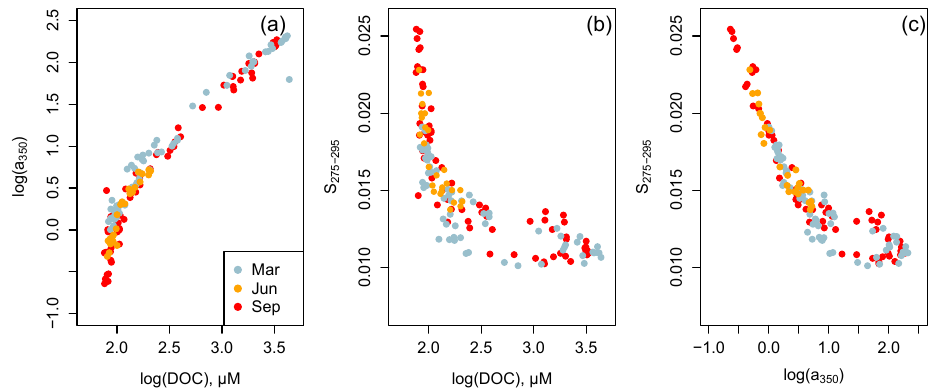
Figure 5. Scatter plots of (a) CDOM absorption versus DOC concentration, (b) S 275–295 versus DOC concentration, and (c) S 275–295 versus CDOM absorption for the entire data set. Strong relationships were found between these parameters but without seasonal